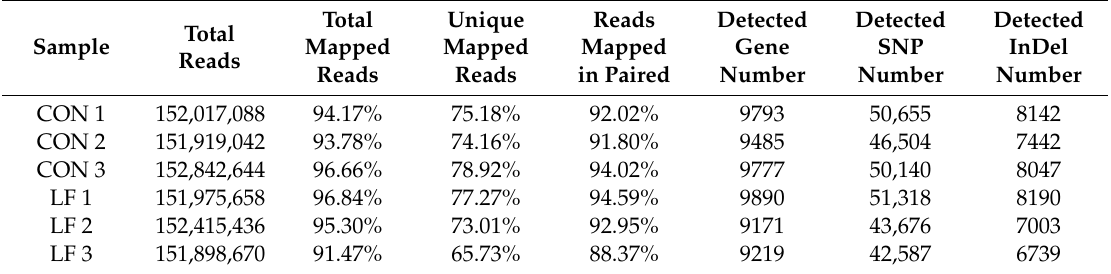
Figure 2. The lncRNAs identified during osteogenic differentiation of CON group and LF group. ( A ) Schematic diagram of the pipeline used for the identification of lncRNAs in rBMSCs. ( B ) The number of lncRNA identification was obtained of four steps. ( C ) Venn diagram showing lncRNAs identified by three types of software. ( D ) Classification of obtained novel lncRNAs according to their genomic positions, distribution of four types of lncRNAs among all 1301 lncRNAs. Table 1. RNA-Seq read mapping summary.